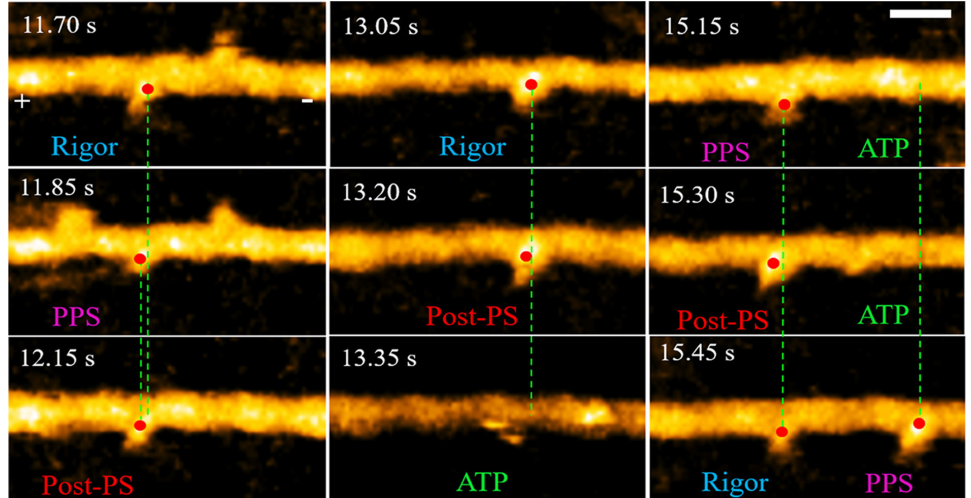
Figure 4. HSAFM images of skeletal HMM chemomechanical cycle: the frames show a double- headed myosin fragment bound to F-actin at different states in 2 µM ATP with the red dot indicating the center of mass. Image created at 6.7 frames per second with a 30 nm scale bar. (PPS: pre-power- stroke, post-PS: post-power-stroke) (adapted from [21] with permission, copyright 2021 American Chemical